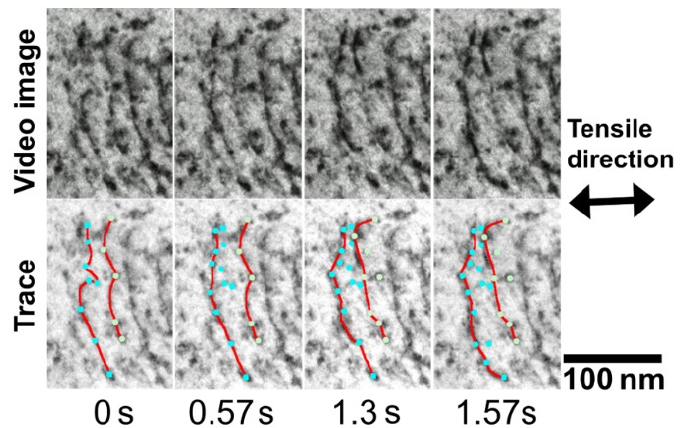
Figure 4. Time-sequential changes in dislocation motion for irradiation sample 2. Upper photos show the corrected images in which the image is normal to the slip plane of dislocations. Bottom photos show the trace images of dislocation and defects that are pinned/depinned. The red lines represent dislocation lines; blue and green dots represent pinning/depinning points.